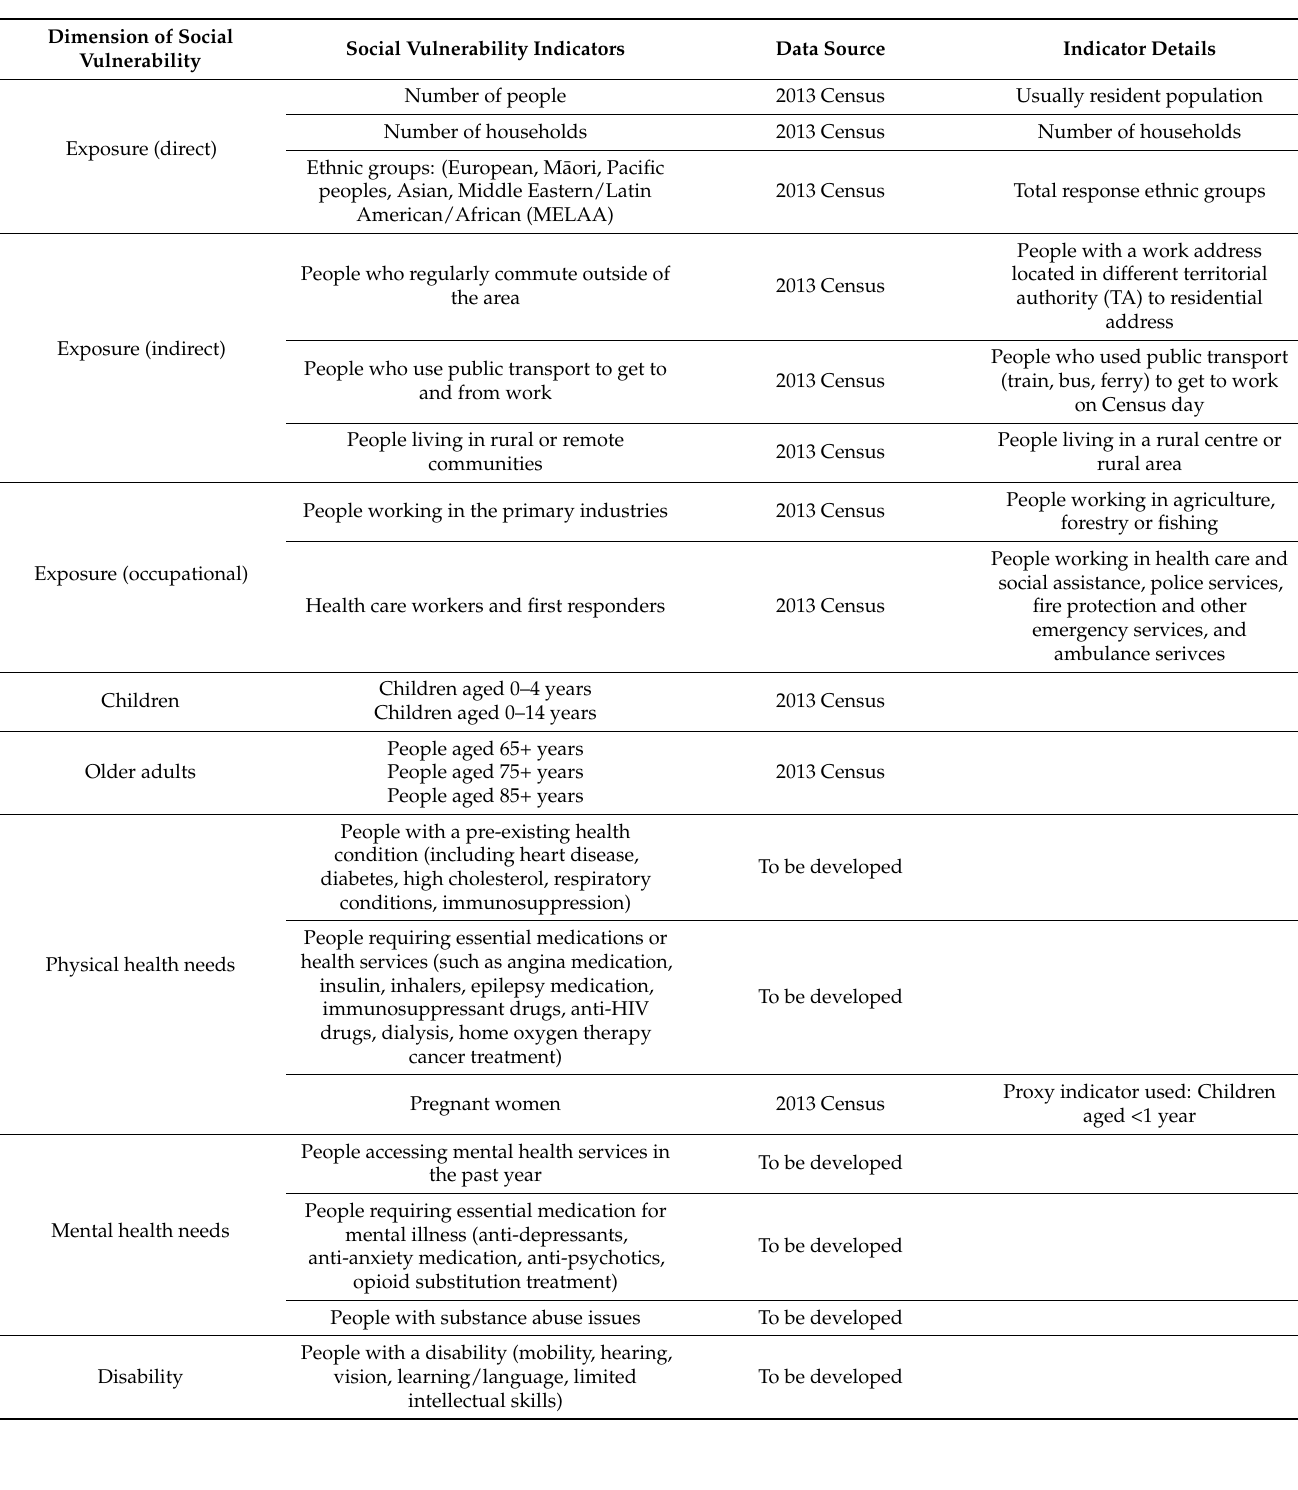
Table A3. Social vulnerability indicators for flooding in New Zealand, full list, 2013